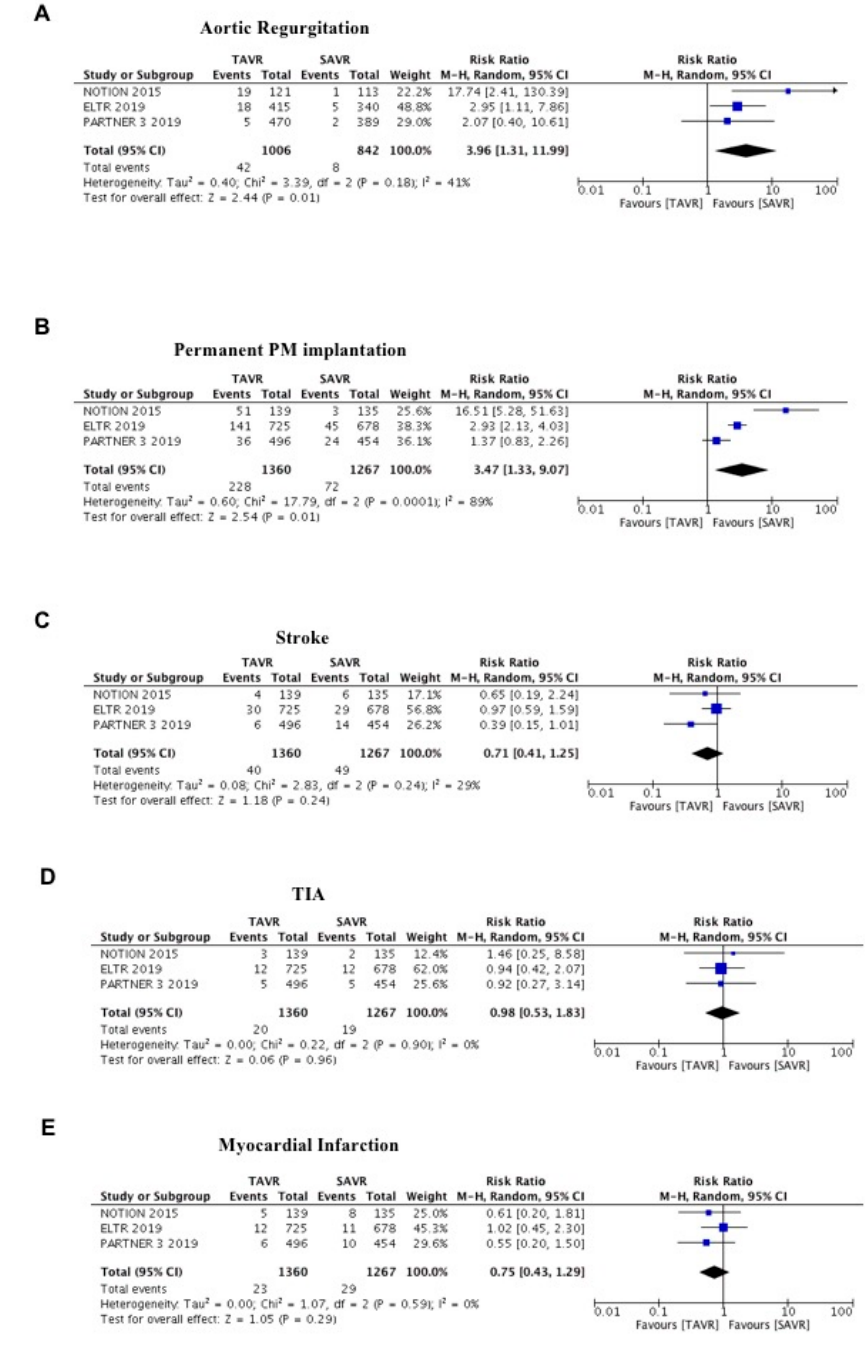
Figure 3. Meta-analysis of aortic regurgitation, permanent PM implantation, stroke, transient ischemic attack (TIA) and myocardial infarction. ( A ) Forest plot and summary e ff ect of the di ff erence in the incidence of aortic regurgitation, showing a significantly lower incidence in the SAVR arm ( p = 0.01). ( B ) Forest plot and summary e ff ect of the di ff erence in the incidence of permanent PM implantation, showing a significantly lower incidence in the SAVR arm ( p = 0.01). ( C ) Forest plot and summary e ff ect of the di ff erence in the incidence of stroke, showing no di ff erence between TAVR and SAVR ( p = 0.24). ( D ) Forest plot and summary e ff ect of the di ff erence in the incidence of TIA, showing no di ff erence between TAVR and SAVR ( p = 0.96). ( E ) Forest plot and summary e ff ect of the di ff erence in the incidence of myocardial infarction, showing no di ff erence between TAVR and SAVR ( p =